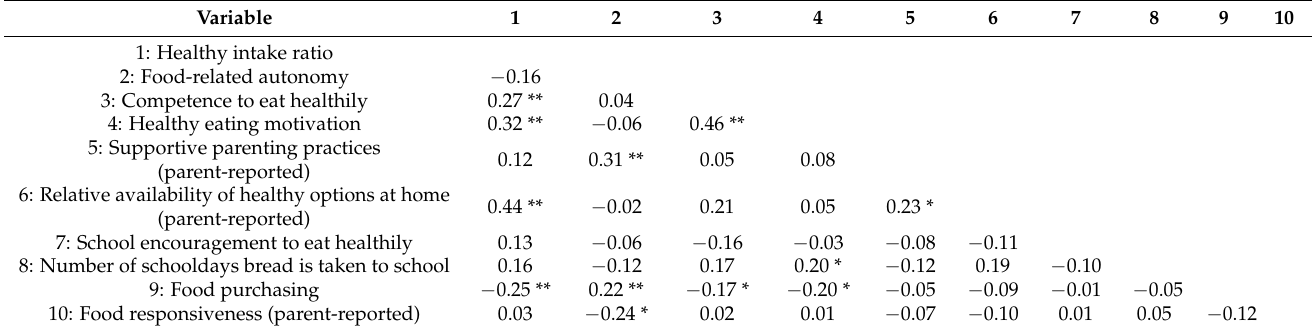
Table 3. Pearson’s correlation coefficients between study variables.